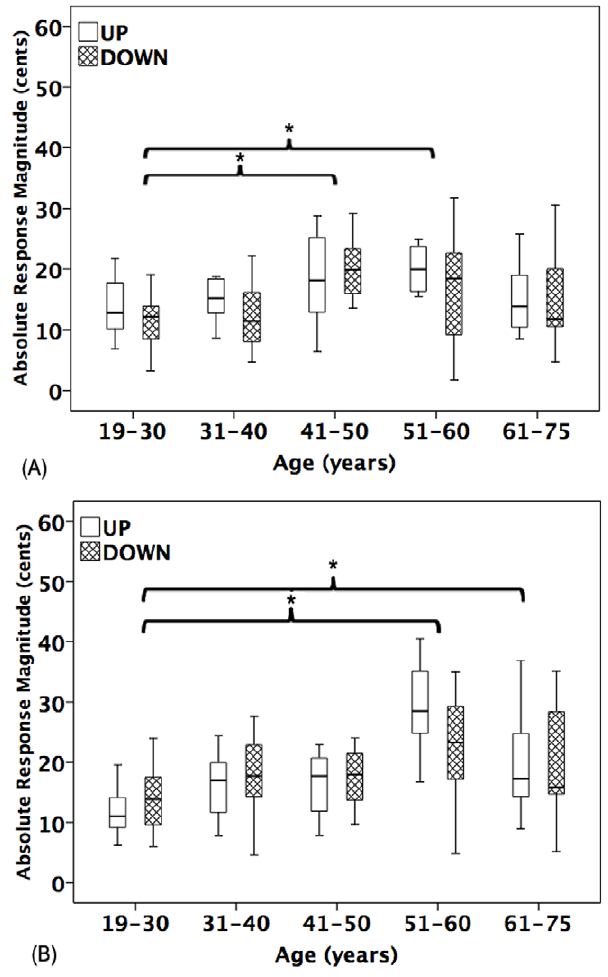
Figure 4. Boxplots of averaged vocal response magnitudes to 50 cents (A) and 100 cents (B) stimuli as a function of age and stimulus direction. The open and shaded boxplots denote the averaged absolute response magnitudes for upward and downward cents pitch-shifted stimuli, respectively. The asterisks indicate significant differences between